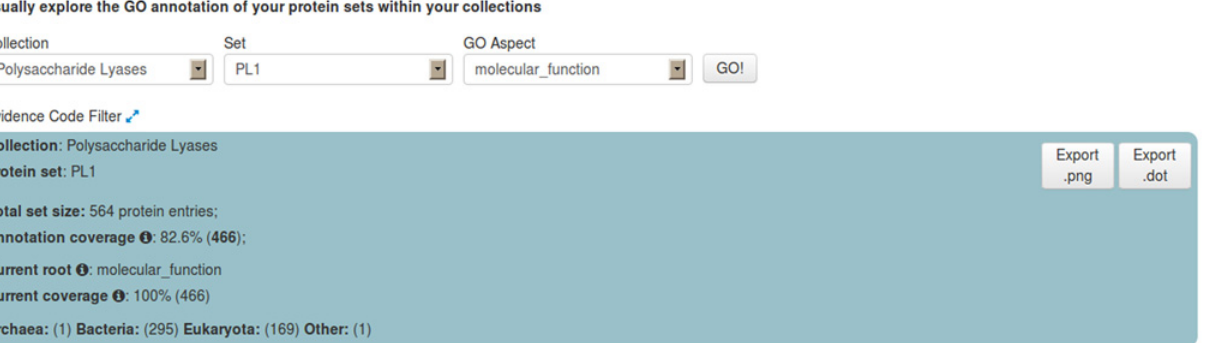
Fig 3. PL1 set summary header. Header with summary statistics regarding the PL1 (CAZy family) Set respective to the GO molecular function sub-ontology annotation coverage.